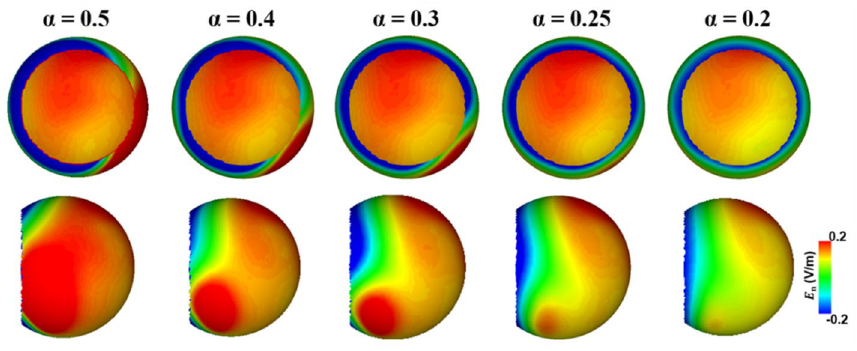
Figure 3. Electric field distributions in the retina based on the value of α within the constraint C3 for the iterative optimization.